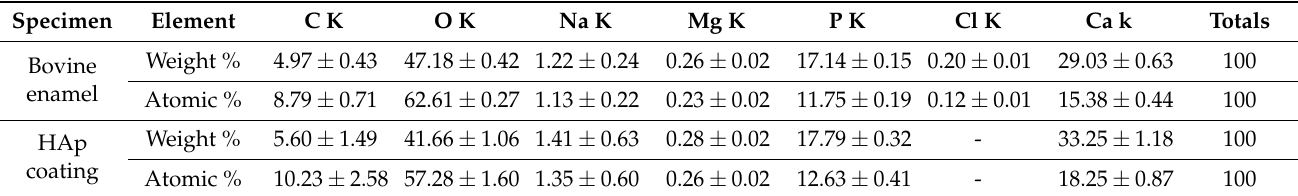
Table 1. Mean values and standard deviations of the elemental compositions of bovine enamel and hydroxyapatite film coating. ( n = 5).